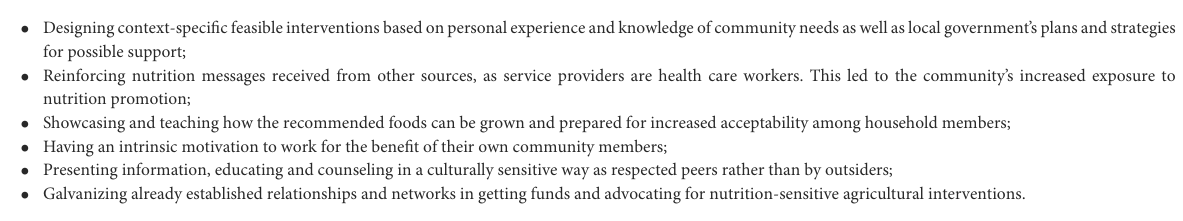
BOX 1 Rural service providers act as catalyzers for dietary behavior change